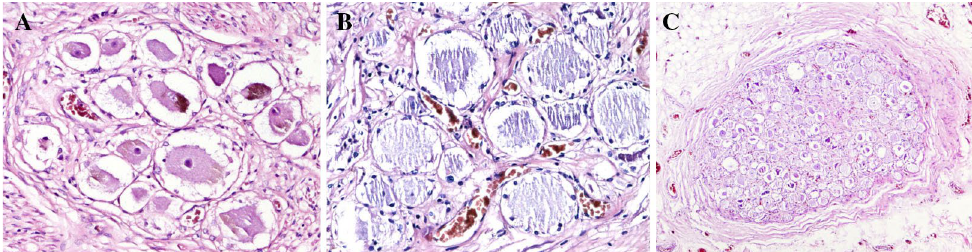
Figure 4. ( A ) (Magnification: 200 times). ( A ) Normal neurons in the ganglion, the cell nucleus is deeply stained, and the shape is normal; ( B ) (magnification: 200 times). After RFA, the neuron cell body produces coagulative necrosis, the nucleus dissipates, and the cell contour remains; ( C ) (magnification: 40 times). Shows the ratio of damaged neurons to the entire ganglion.